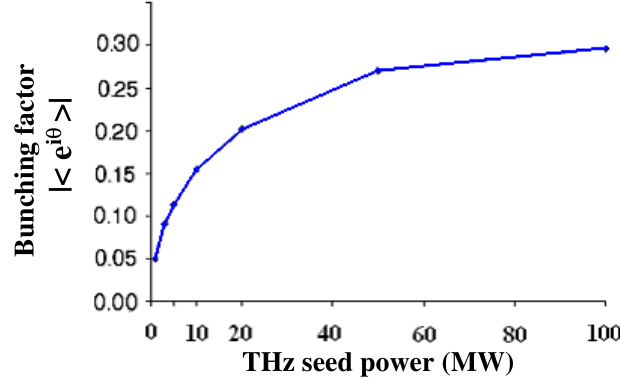
FIG. 4. (Color) Bunching factor of an electron beam after prop- agating in a 30 cm long, K (cid:3) 2 : 85 prebuncher seeded with various powers of 100 (cid:1) m pulses.